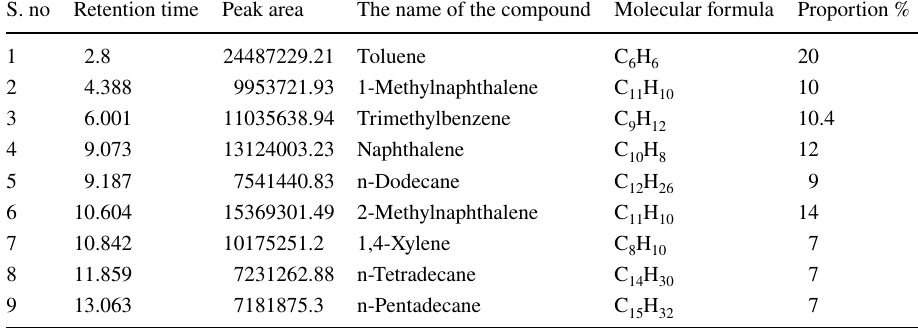
S. no Retention time Peak area The name of the compound Molecular formula Proportion